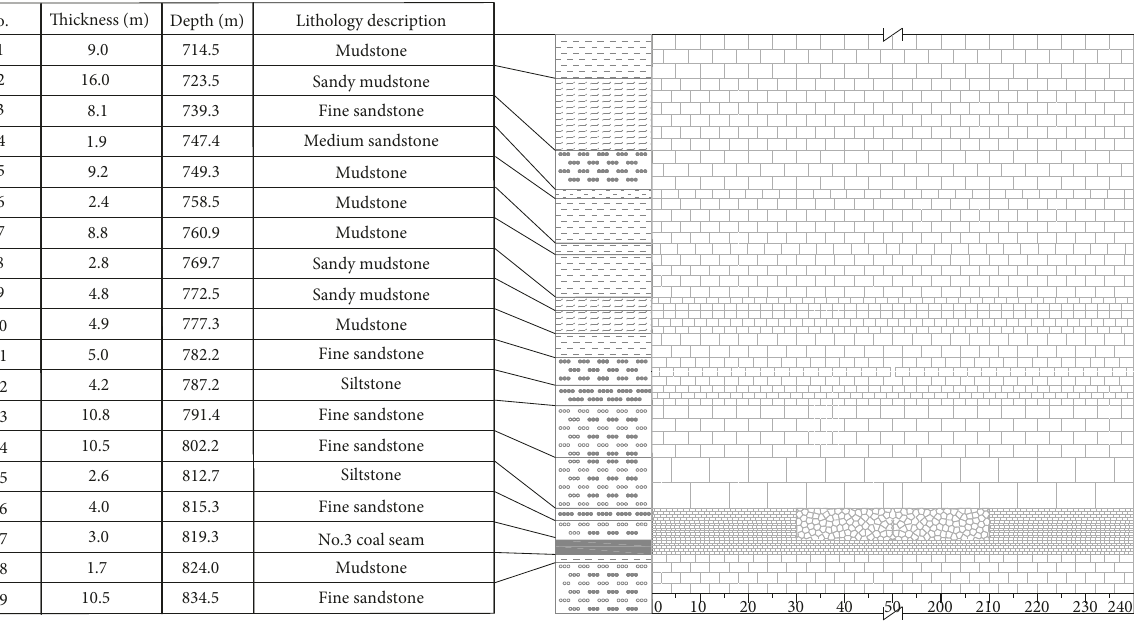
Figure 1: Coal seam comprehensive histogram and UDEC numerical simulation model. Table 1: Mechanical parameters of coal seam and overlying